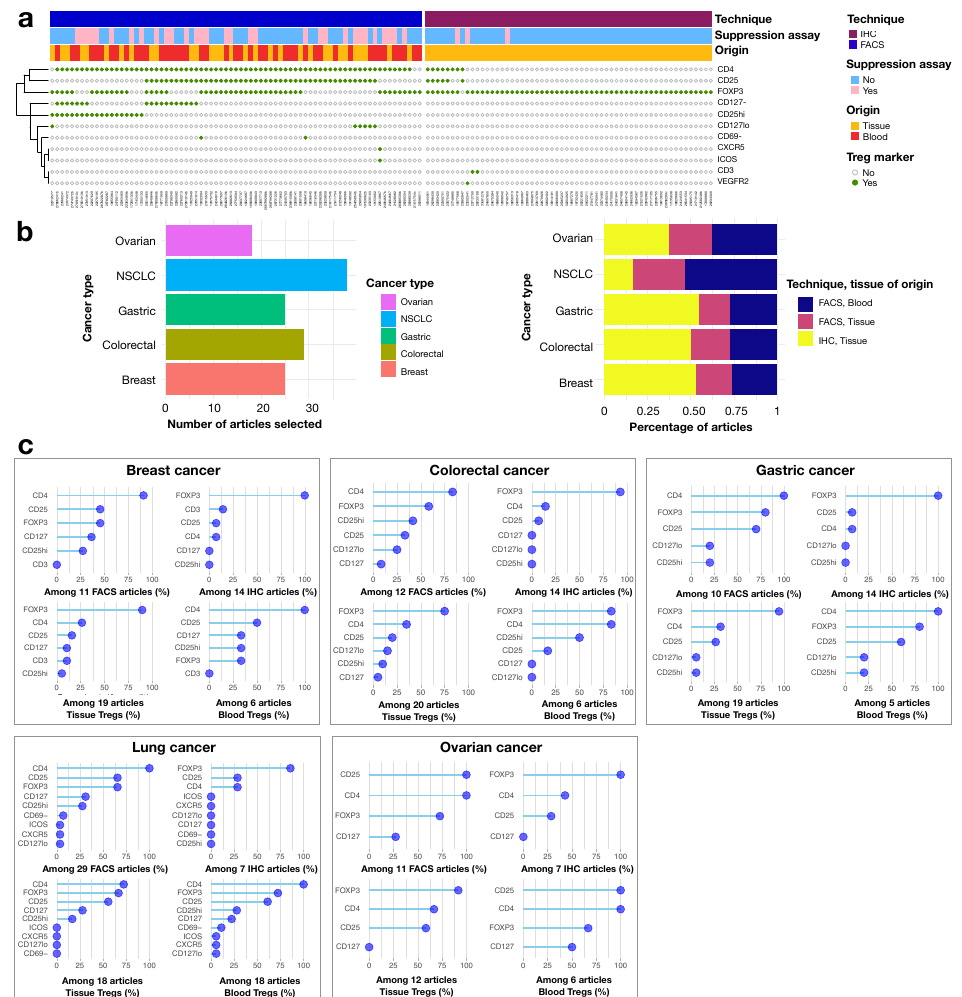
Figure 2. Treg markers used to identify Tregs in published articles on cancer. ( a ) The heatmap provides a clearer picture of the markers and combinations of markers most widely used to define human Tregs, based on 112 published articles on cancer. Each row corresponds to a marker and each column corresponds to an article. The heatmap on the left summarizes the markers used for FACS, together with a clustering of markers to represent common co-occurrences. The heatmap on the right summarizes the markers used for immunohistochemistry (IHC). It also indicates whether the suppression capacities of Tregs were tested in a functional assay, and the tissue from which the Tregs were obtained. ( b ) Histogram of number of articles included per cancer type (left), normalized histogram per cancer type, color-coded according to the technique used for Treg detection and the tissue of origin (right). ( c ) Lollipop graphs depicting the frequency of use of each Treg marker, by cancer type, technique for Treg detection and tissue of